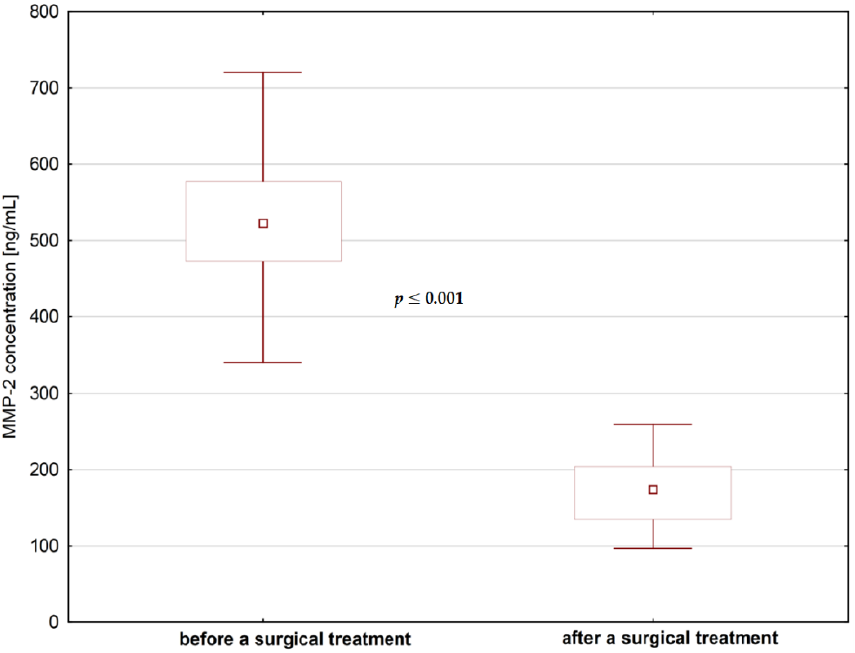
Figure 6. The concentrations of fibronectin in saliva before and after surgical treatment. Before the dental treatment, we did not find any correlation between MMP-1 and MMP-2 levels in saliva, but there was an average positive correlation between MMP-1 and MMP-2 concentrations in saliva after dental treatment. We also found a negative weak correlation between MMP-2 and fibronectin concentrations after dental treatment. 5. Discussion Testing of saliva is non-invasive, cheap and easy. Salivary composition can change quickly, so its analysis could be important in monitoring the severity of the diseases [1,2]. Samples of saliva should be taken after dental examination because bleeding from the gums can cause the contamination of samples [1,2].